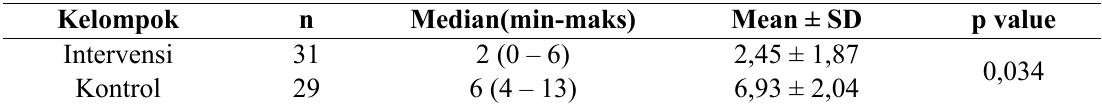
Tabel 4. Analisis perbedaan perubahan kondisi depresi antara lansia yang mendapatkan dan